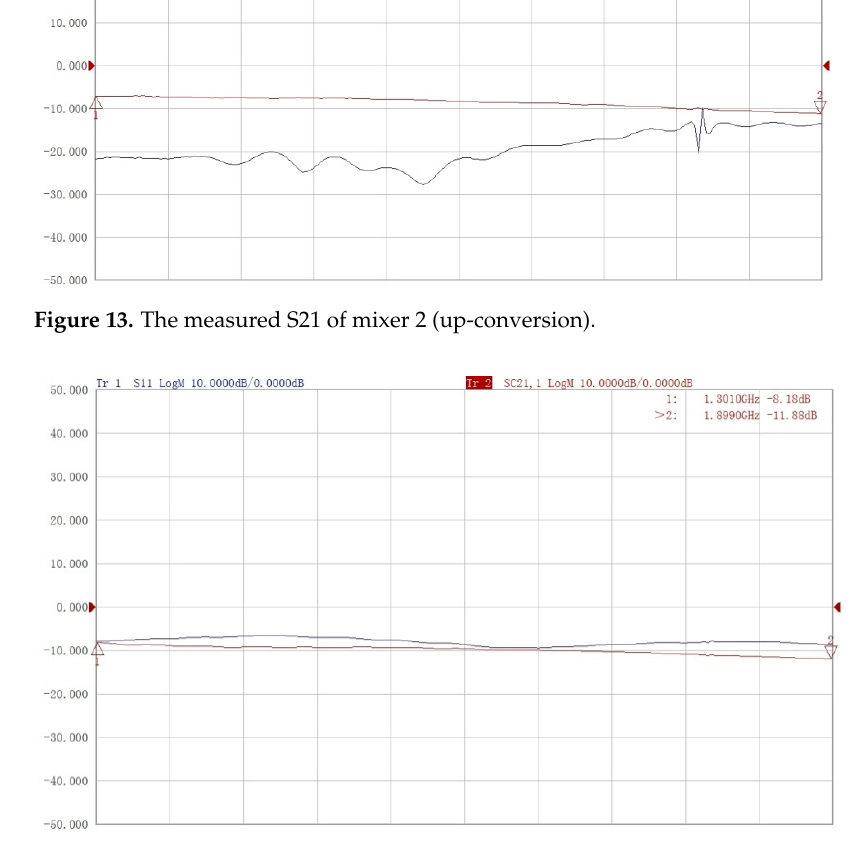
Figure 14. The measured S21 of mixer 2